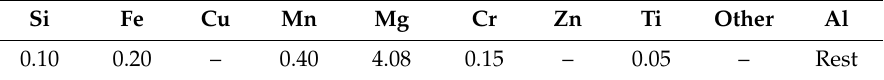
Table 1. Chemical composition (% by weight) of the EN AW-5182 alloy.